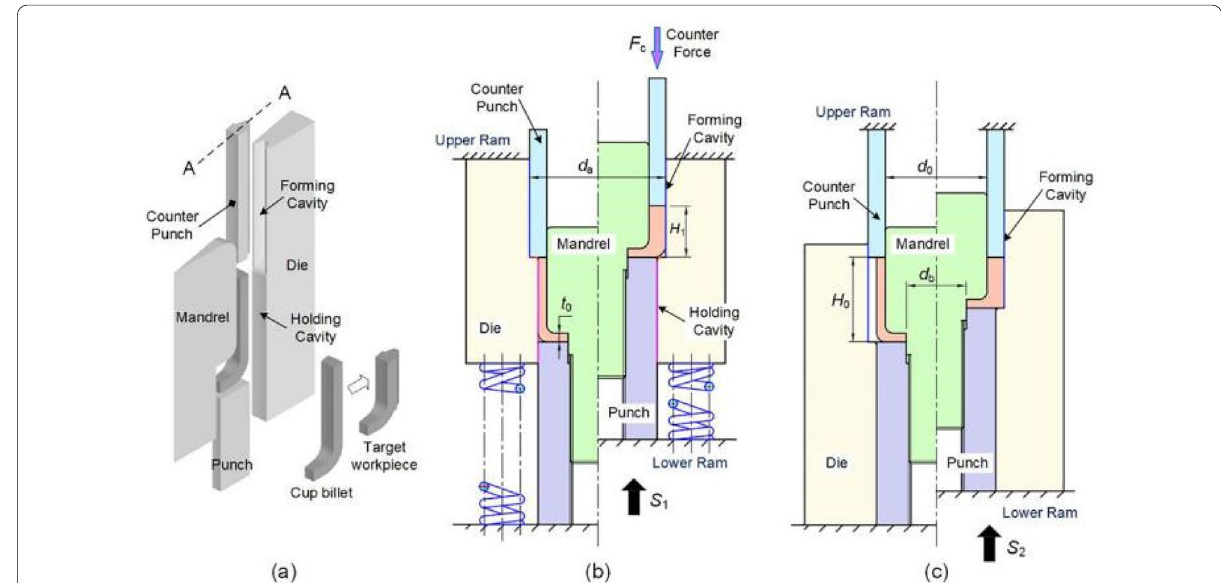
Figure 3 Forming principle: ( a ) digital model, ( b ) presentation of section A-A based on U-CDZ method, ( c ) presentation of section A-A of conventional upsetting method (nomenclature based on Figure 1)